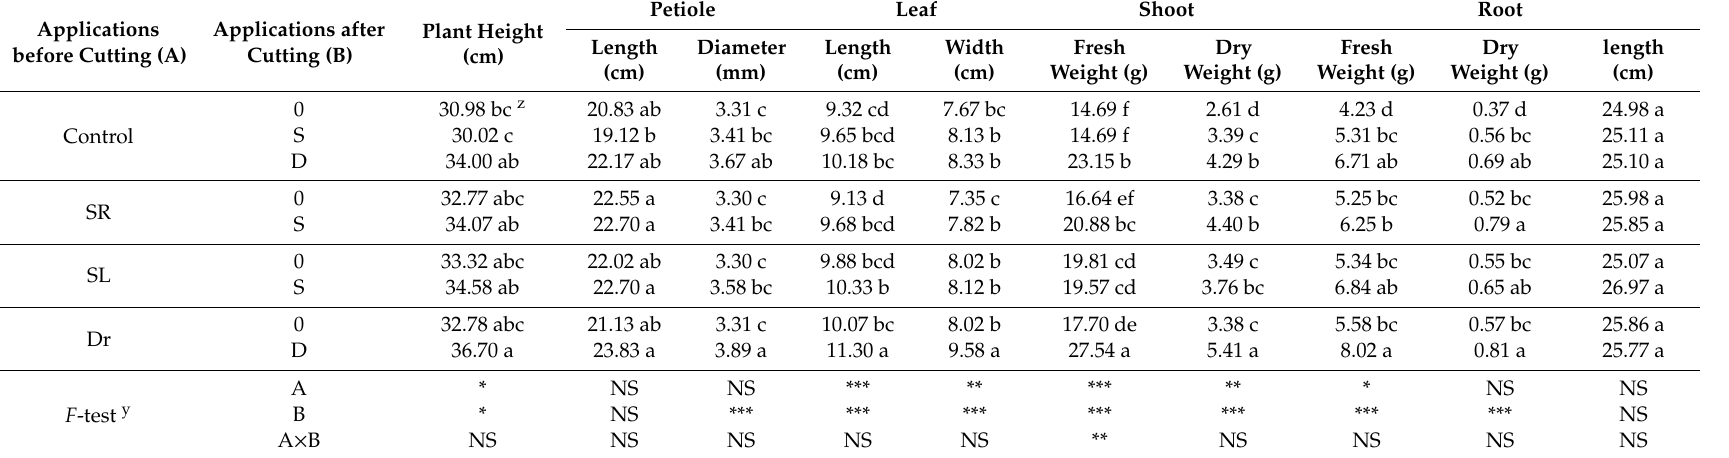
Table 1. Growth of strawberry daughter plants under di ff erent